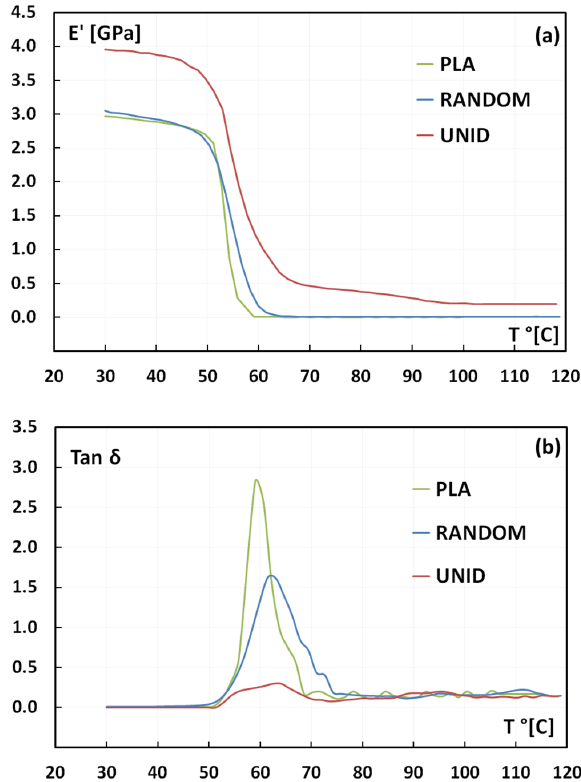
Figure 7. Temperature dependence of ( a ) storage modulus E ’ and ( b ) tan delta.